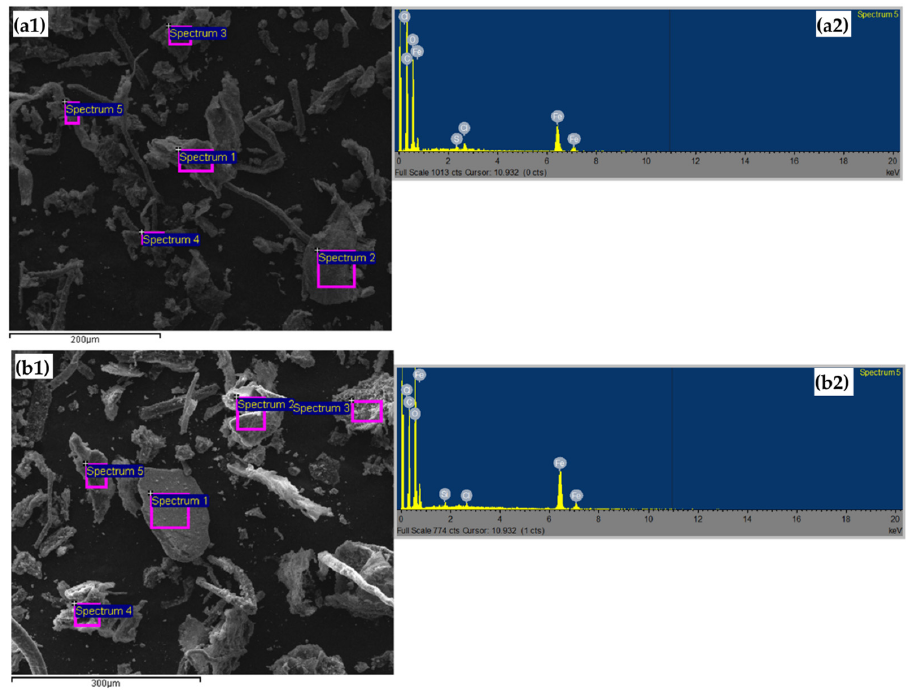
Figure 8. EDS micrographs and spectra for CNC-MNPs ( a1 , a2 ) and CPC-MNPs ( b1 , b2 ).